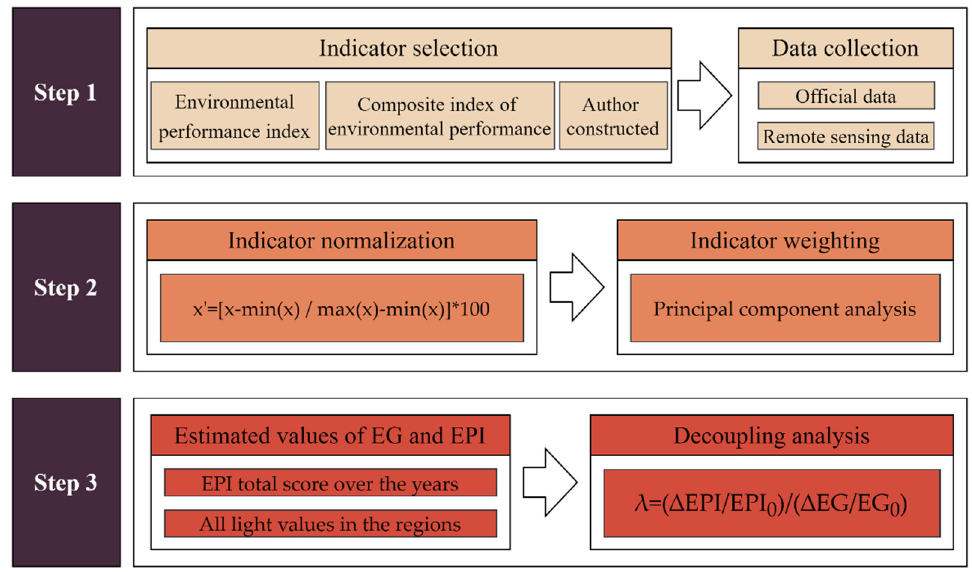
Figure 1. Three interrelated steps were involved in the assessment and analysis of the economic and environmental decoupling performance in